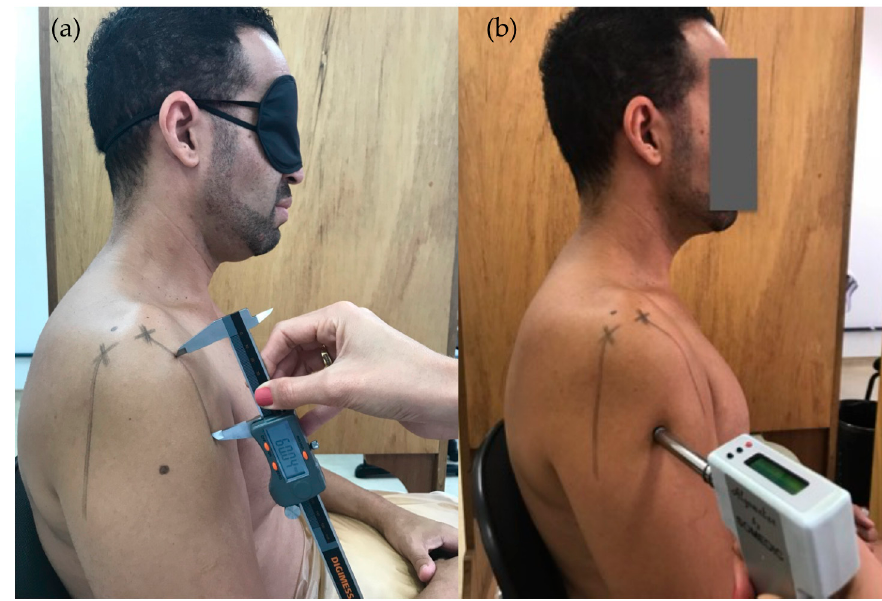
Figure 1. ( a ) Two-point discrimination threshold testing with representation of anterior and posterior lines to guide testing; ( b ) pressure pain threshold testing locally (deltoid muscle) at the